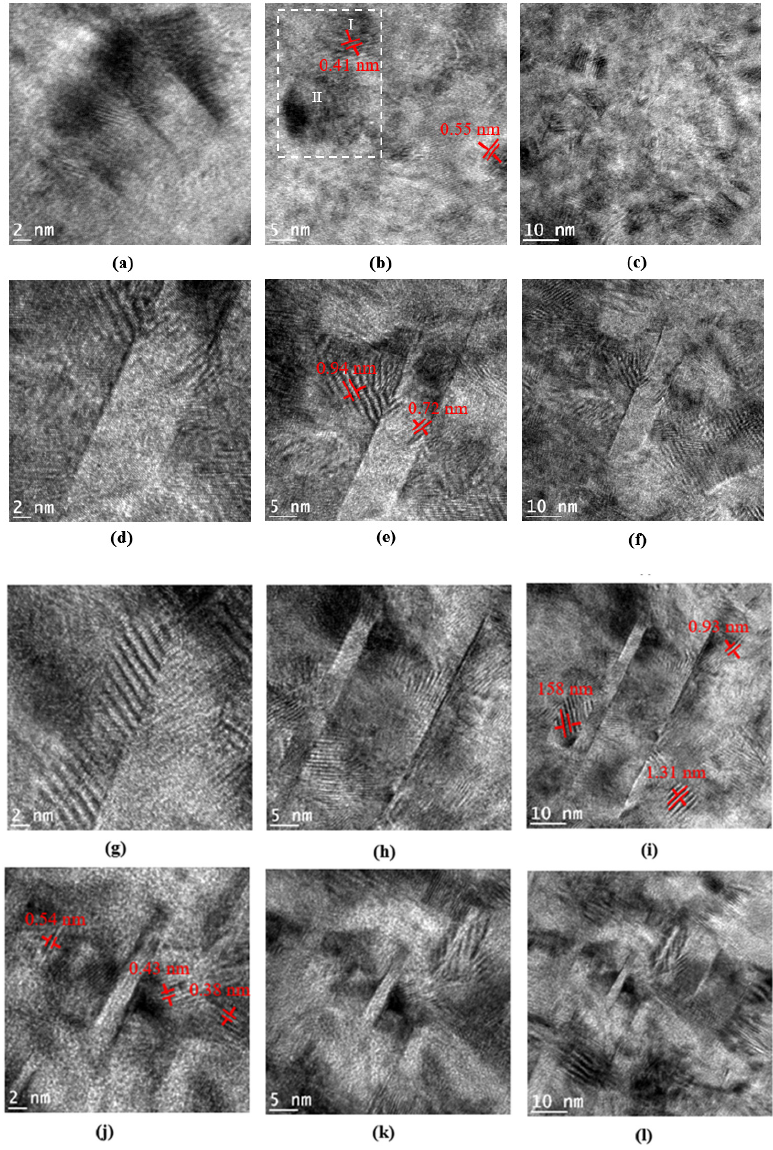
Figure 13. BF–TEM images of DC–electrodeposited NiW ( a – c ); NiW–SiC ( d – f ); NiW–hBN ( g – i ), and NiW–hBN–SiC ( j – l ) at different resolutions.